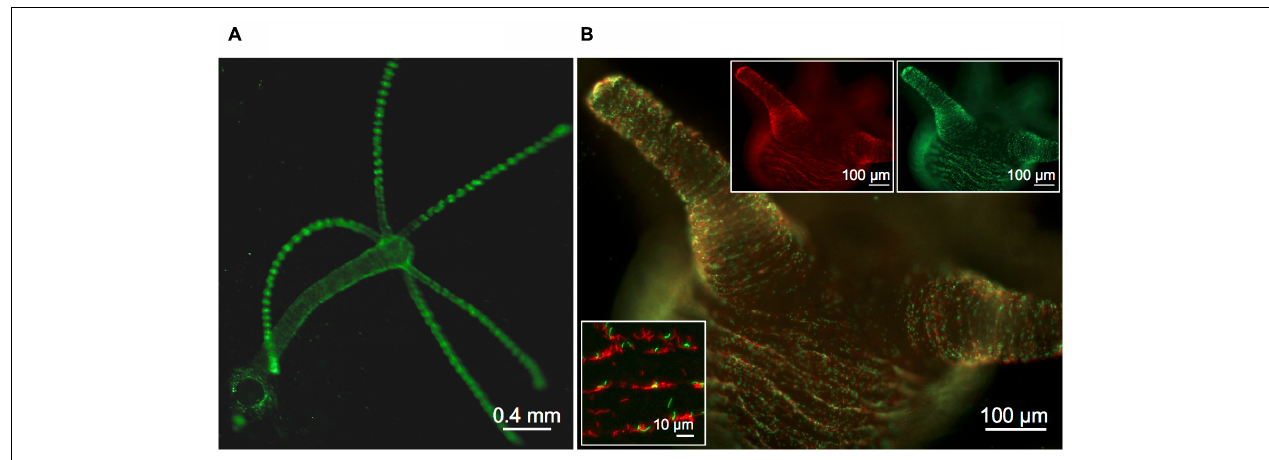
FIGURE 1 | Visualization of fluorescently labeled Curvibacter . (A,B) Micrographs of a previously sterile polyp visualized 72 h post-infection with 6 × 10 3 cells per polyp of Curvibacter carrying plasmid pRL153-GFP (green) or plasmid pTW1-mCherry (red). (A) Overview of a Hydra polyp densely colonized by GFP-expressing Curvibacter . (B) Side-view on the Hydra head region with mixed populations of GFP- and mCherry-expressing Curvibacter . White boxes: Fluorescence signals of the GFP- (top right) and mCherry-labeled population (top left). Close-up of Curvibacter cells densely settling in the proximity of the polyp’s folding molds (bottom